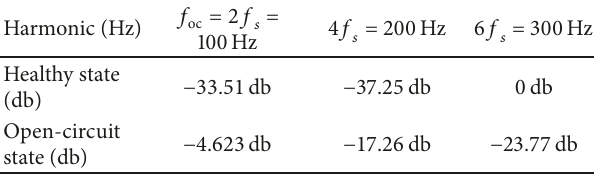
Table 3: Amplitudes and frequencies of